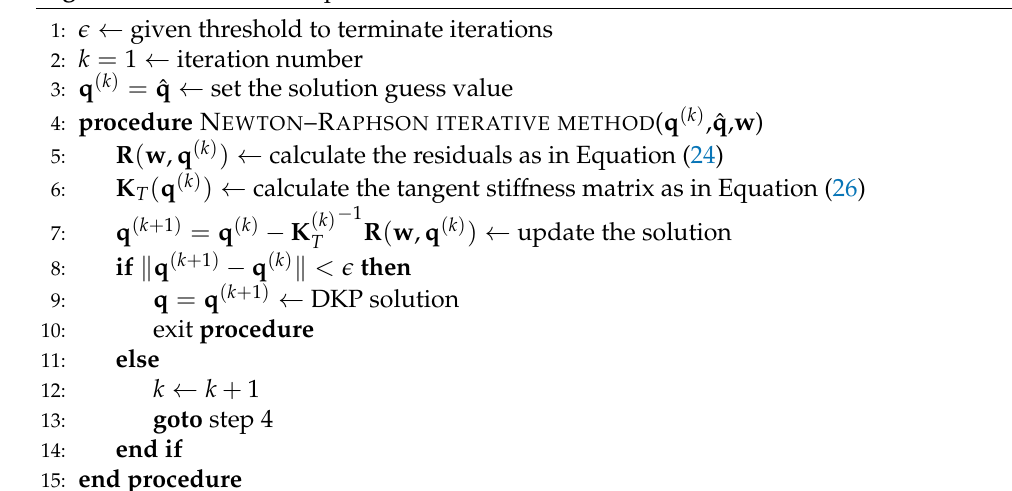
Algorithm 1 : Newton–Raphson iterative